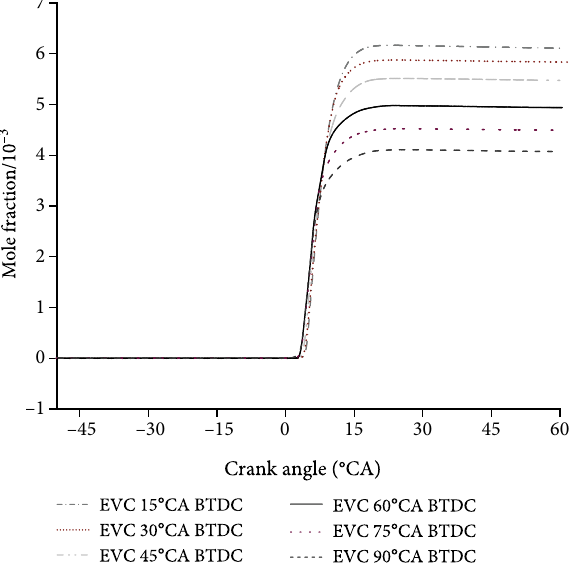
Figure 9: In fl uence of advanced EVC on pressure rise rate.